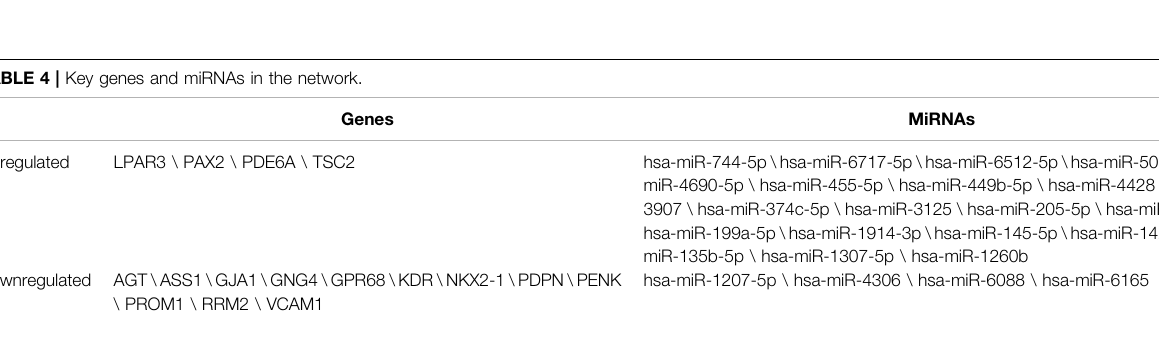
TABLE 4 | Key genes and miRNAs in the